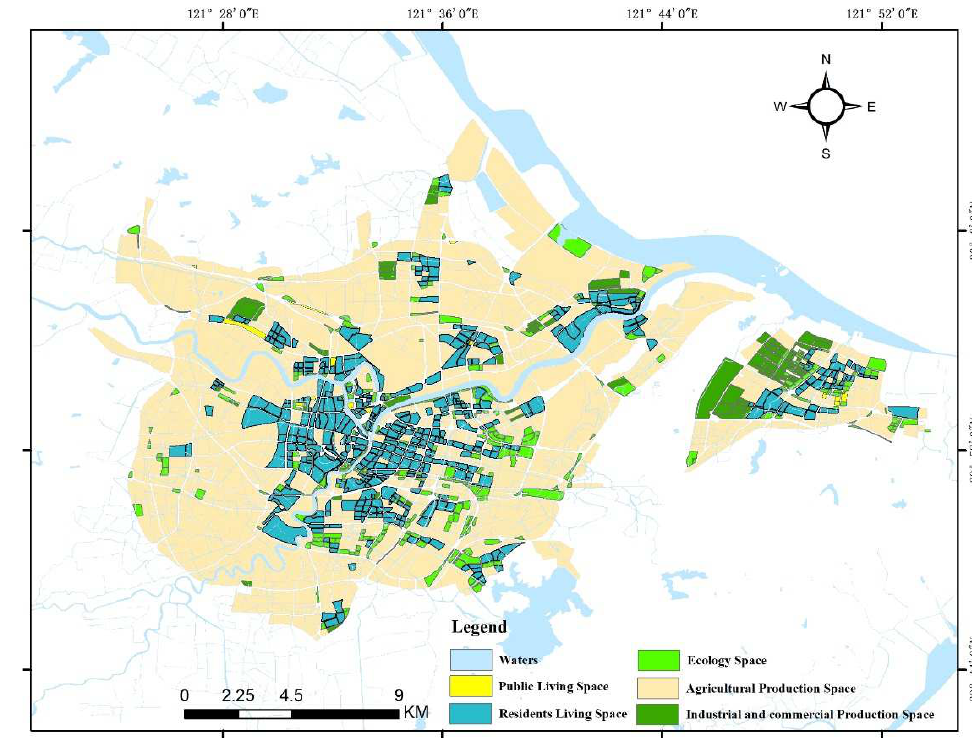
Figure 8. PLES layout of Ningbo City.